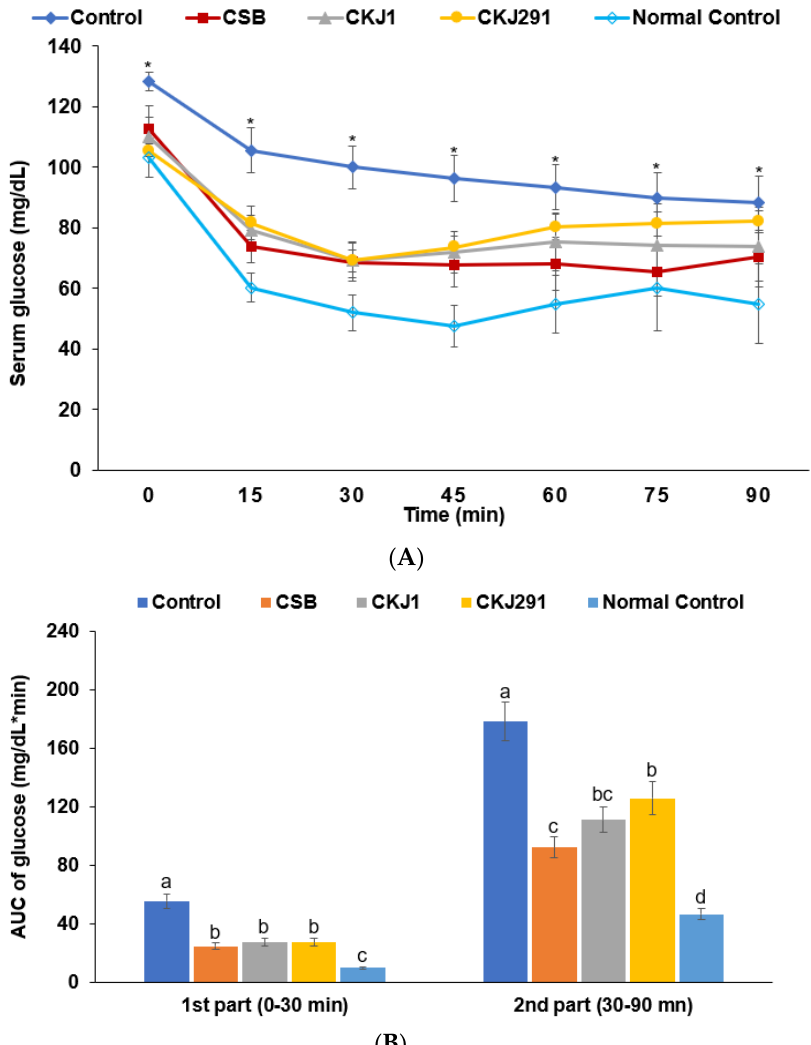
Figure 5. Intraperitoneal insulin tolerance test (IPITT). The gerbils underwent an IPITT with 1 IU insulin/kg body weight after 6 h food deprivation on the following day of OGTT. The changes of serum glucose levels during 90 min ( A ) and AUC of serum glucose in the first part (0–30 min) and the second part (30–90 min) during the IPITT ( B ). * Significantly different among the groups at p < 0.05. Bars and dots represent means ± SD ( n = 10). a,b,c,d Means on the bars with different letters were significantly different by Tukey’s test at p < 0.05.